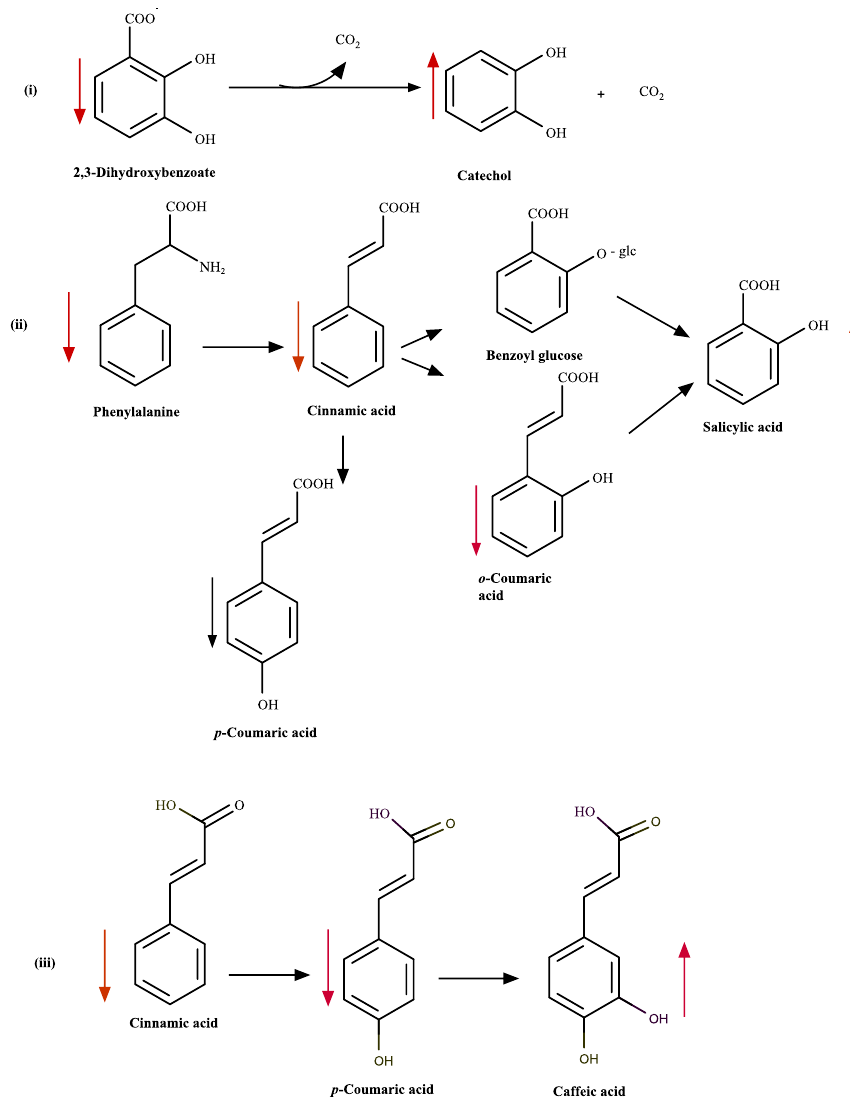
Figure 3. Possible chemical transformations that might have occurred to some of the metabolites of A. macrostachyum water and 50% EtOH extracts during oven-drying at 40 °C. Chemical structures were drawn using Marvin 20.21.0 (https:// www. chema xon.